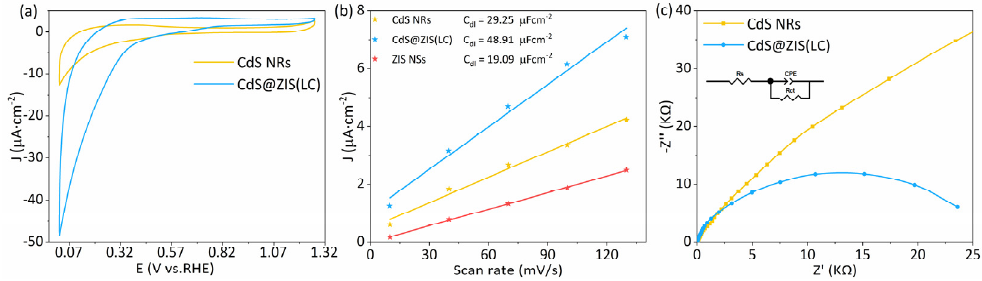
Figure 4. ( a ) CV measurements of CdS NRs and CdS@ZIS at a scan rate of 50 mV/s. ( b ) Linear fitting of capacitive currents versus scan rates under dark condition. ( c ) EIS Nyquist plots of CdS NRs and CdS@ZIS (LC). The inset shows the corresponding equivalent circuit.